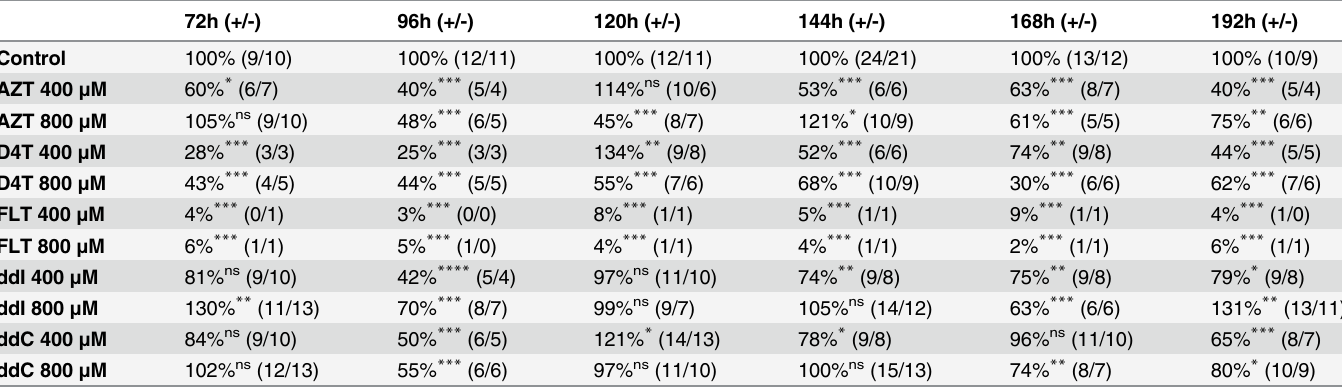
Table 1. Relative quantities of mtDNA compared to unexposed